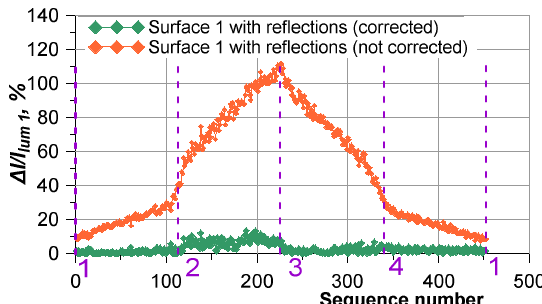
Fig . 6 . Relative error before and after correction